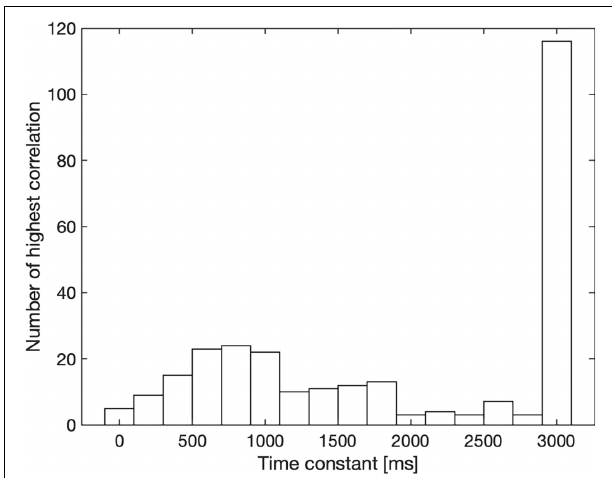
FIGURE 4 | Release time constants for long-term loudness that yielded the highest correlation between line length and calculated long-term loudness for each participant and sound. The number of occurrences within 200-ms wide bins is shown on the ordinate. The search ranged from 0 to 3,000